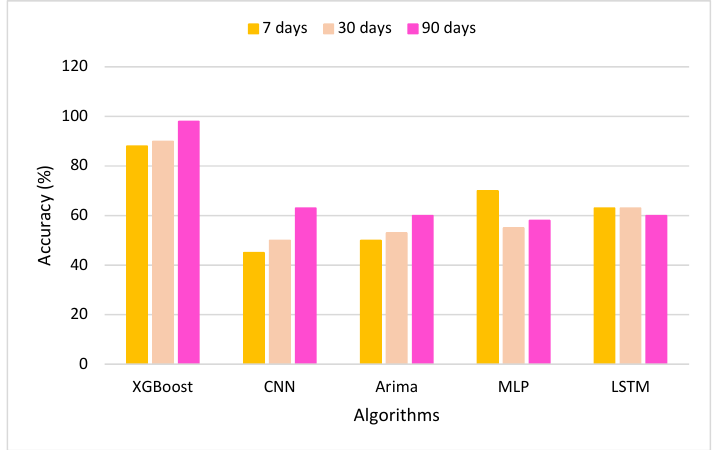
Figure 13. Accuracy of the classification